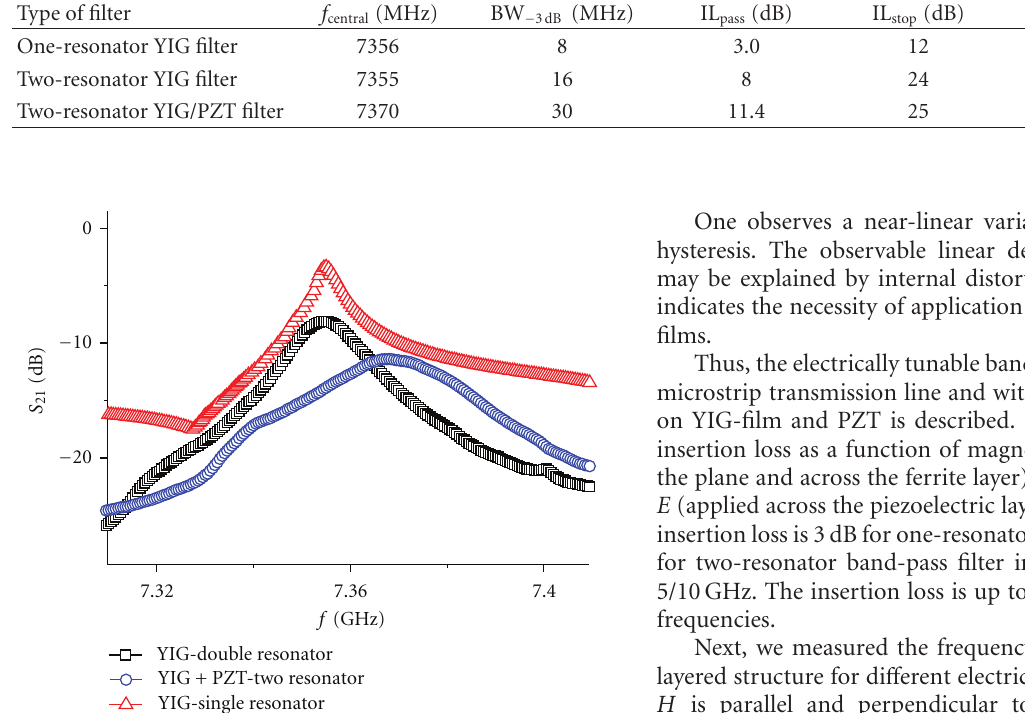
Figure 6: One-resonator filter as compared to two-resonator band- pass filter.